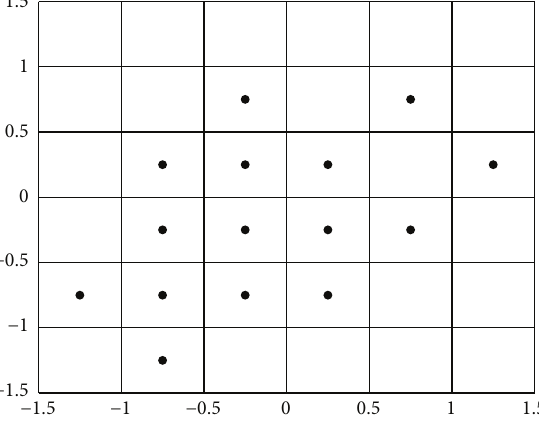
Figure 2: Array configuration for 15 elements.